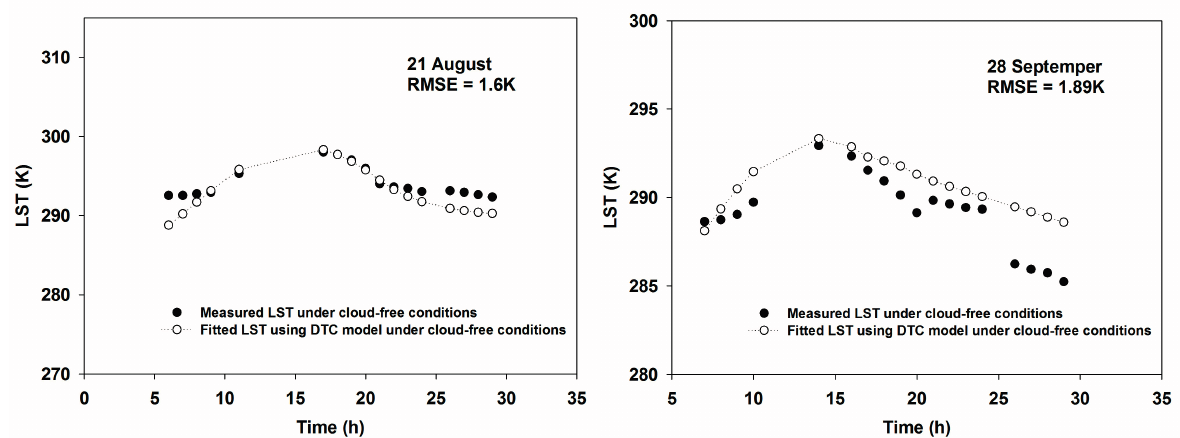
Figure 2. Comparison of the measured daily temperature evolution with that predicted by the DTC model for six days under various cloud